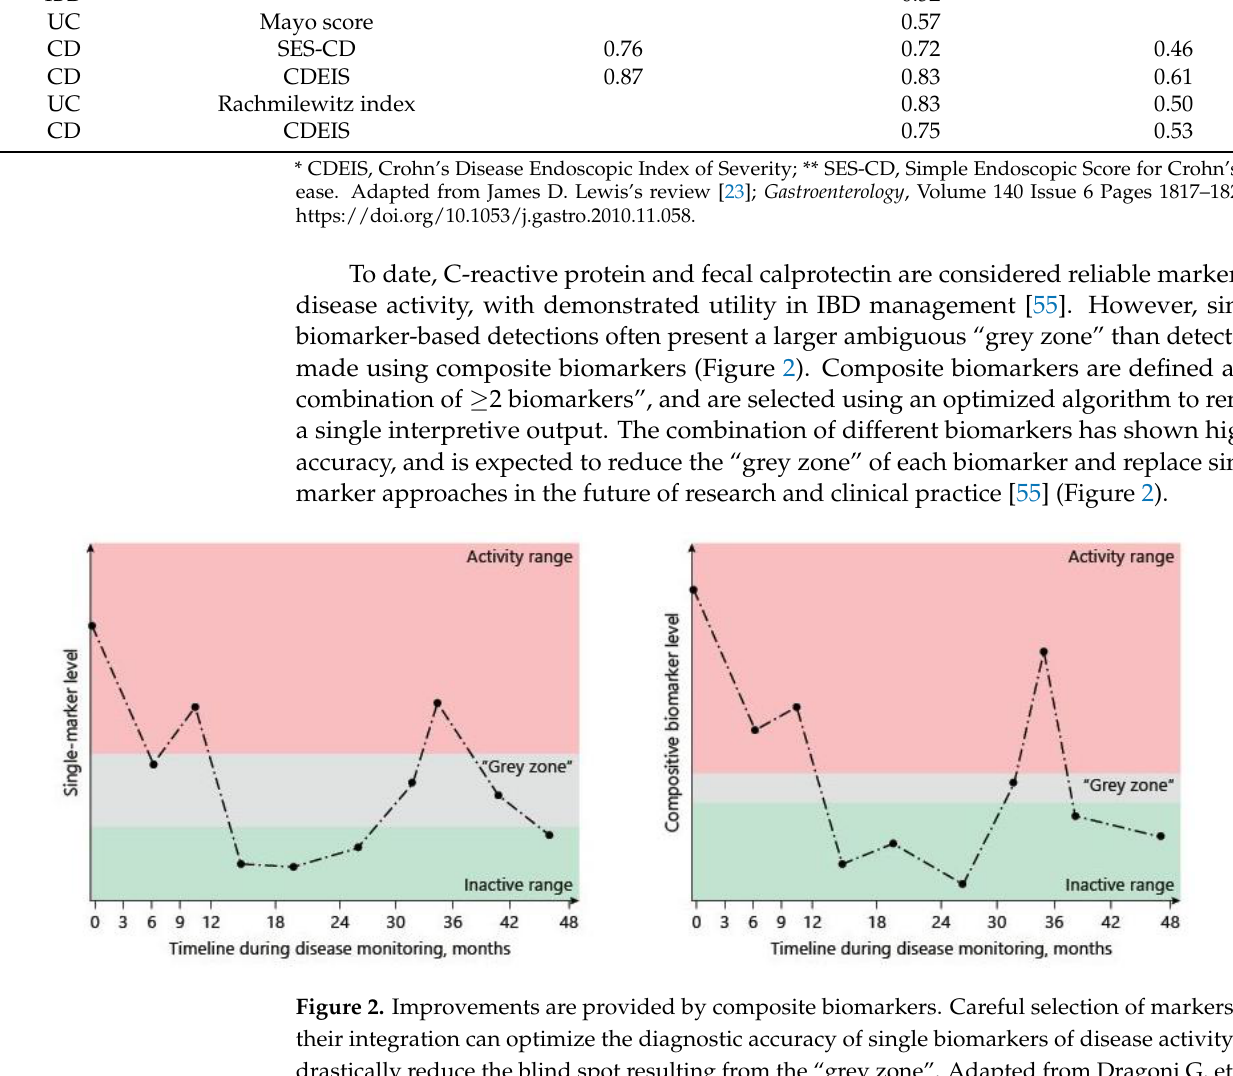
Table 1. Correlation of biomarkers with disease activity, determined by endoscopy.